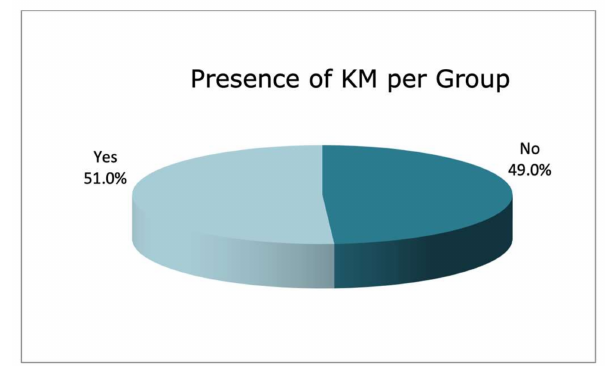
Figure 1. Presence of